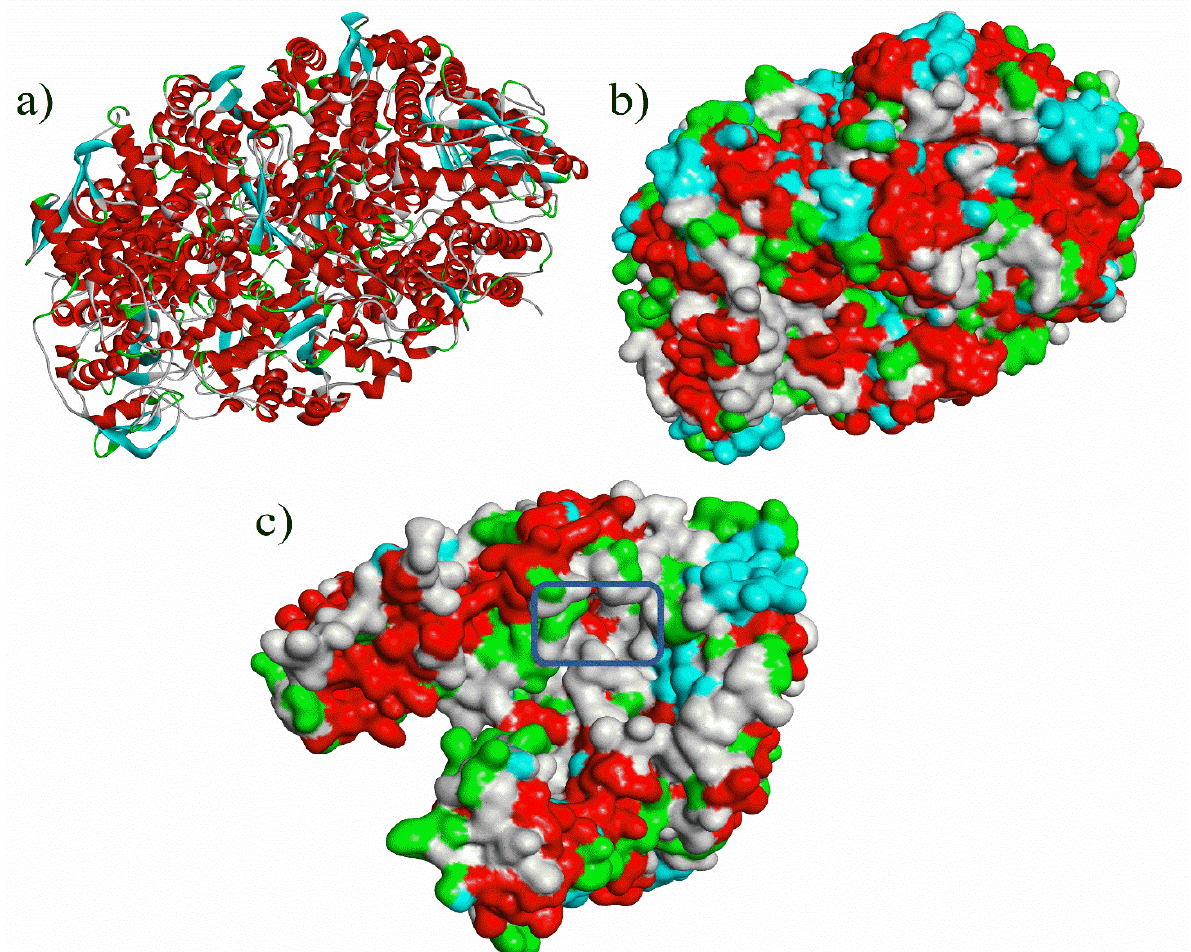
Figure 1. 3D structure of Methyl co-enzyme M reductase (PDB ID—5A8K) ( a ) 3D protein ribbon structure of 5A8K (chains A to F); ( b ) 3D protein ribbon structure with surface pockets (chains A to F); and ( c ) 3D surface structure of active pocket of Methyl co-enzyme M reductase (PDB ID—5A8K) (chains A to C). Table 2. Active site predicted for methyl-coenzyme M reductase (PDB ID—5A8K). Chain Residues Chain